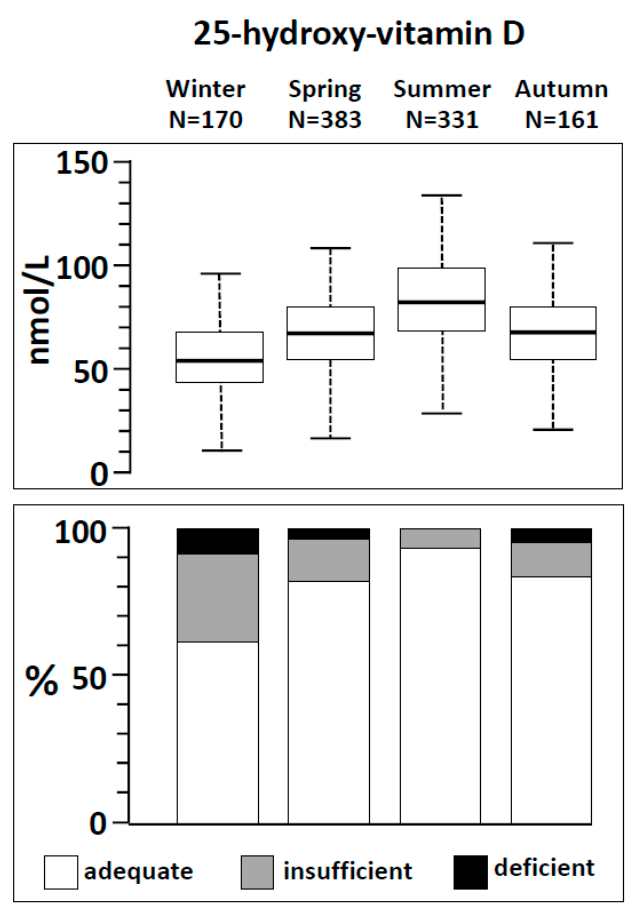
Figure 1. Upper panel. Box-plot of the circulating concentrations of 25-hydroxy-vitamin D across the four seasons. The boxes include values between the 1st and the 3rd quartile (i.e., the interquartile range). The whiskers include values between: 1st quartile − 1.5 times interquartile range and 3rd quartile + 1.5 times interquartile range. Lower panel. Frequency of adequate, insufficient or deficient concentrations of 25-hydroxy-vitamin D according to seasonality.